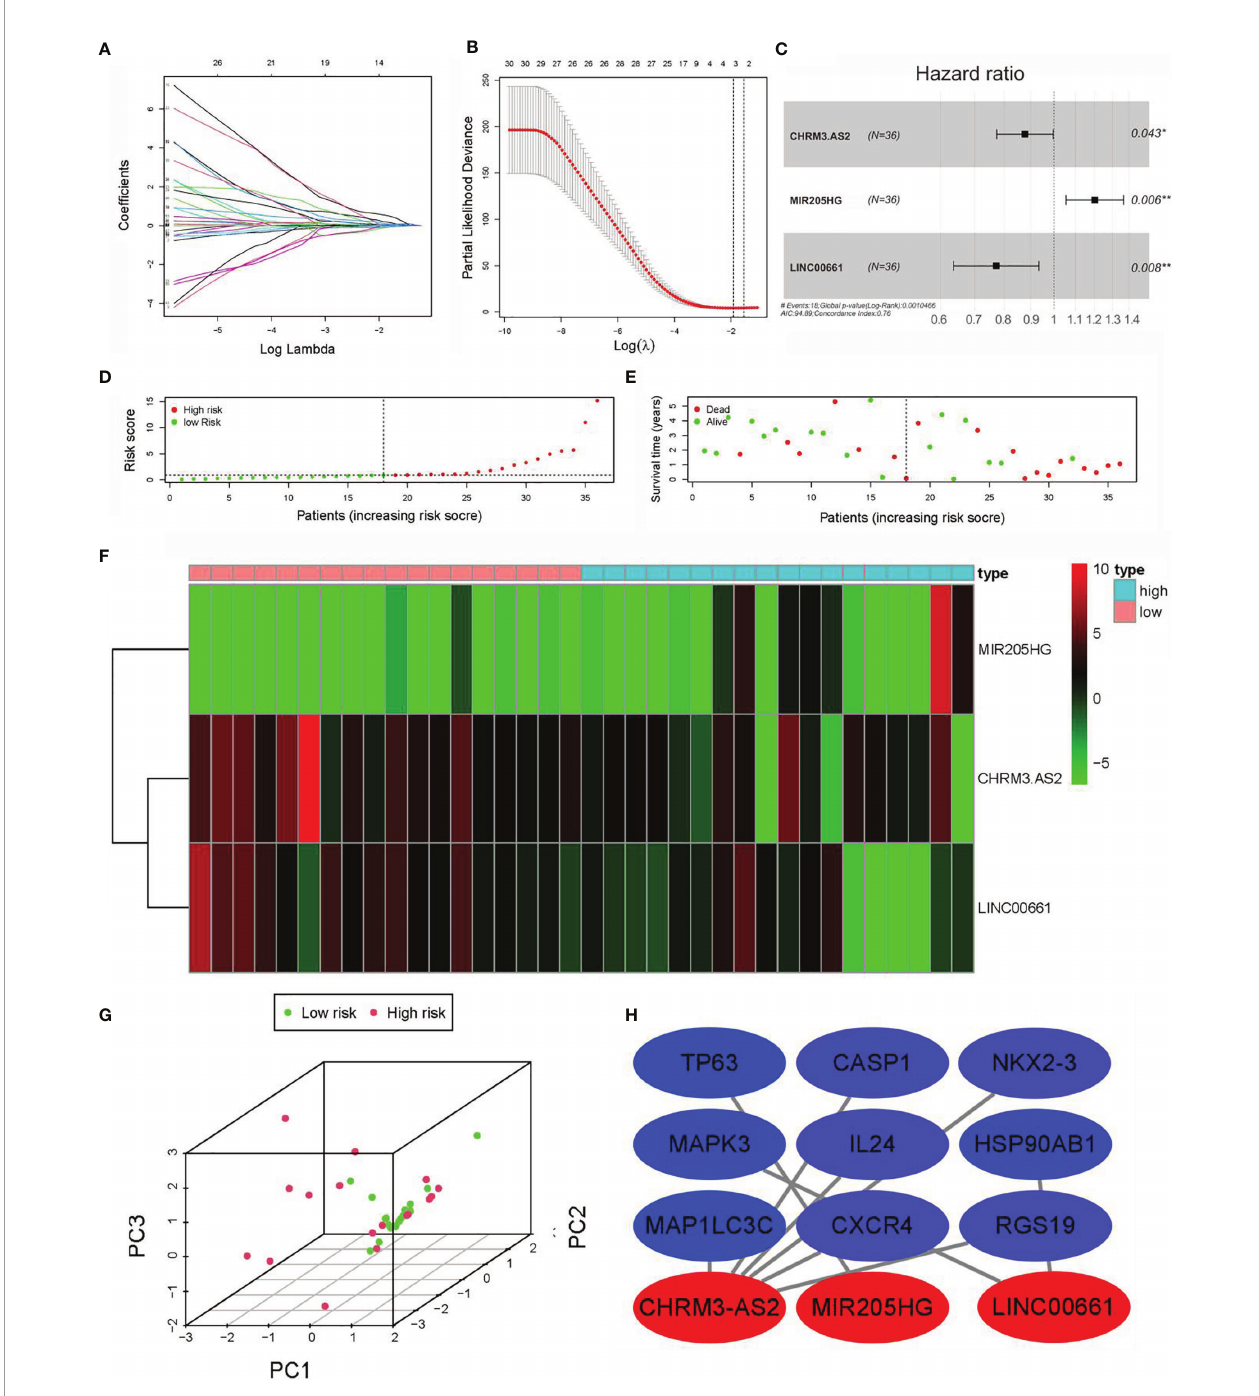
FIGURE 3 | Construction of prognostic DEARlncRNA signatures for CCA patients based on TCGA data. (A) univariate Cox regression analysis. (B) LASSO- penalized Cox regression analysis. (C) Multivariate Cox regression analysis. (D) Distribution of CCA patients with high and low risk based on TCGA data. (E) Survival status of CCA patients with high and low risk based on TCGA data. (F) The heatmap of the three DEARlncRNAs expression pro fi les in high- and low-risk CCA patients. (G) PCA of the expression pro fi les of CHRM3.AS2, MIR205HG, and LINC00661. (H) Coexpression relationship of CHRM3.AS2, MIR205HG, and LINC00661 with corresponding ARGs (*P < 0.05, **P <